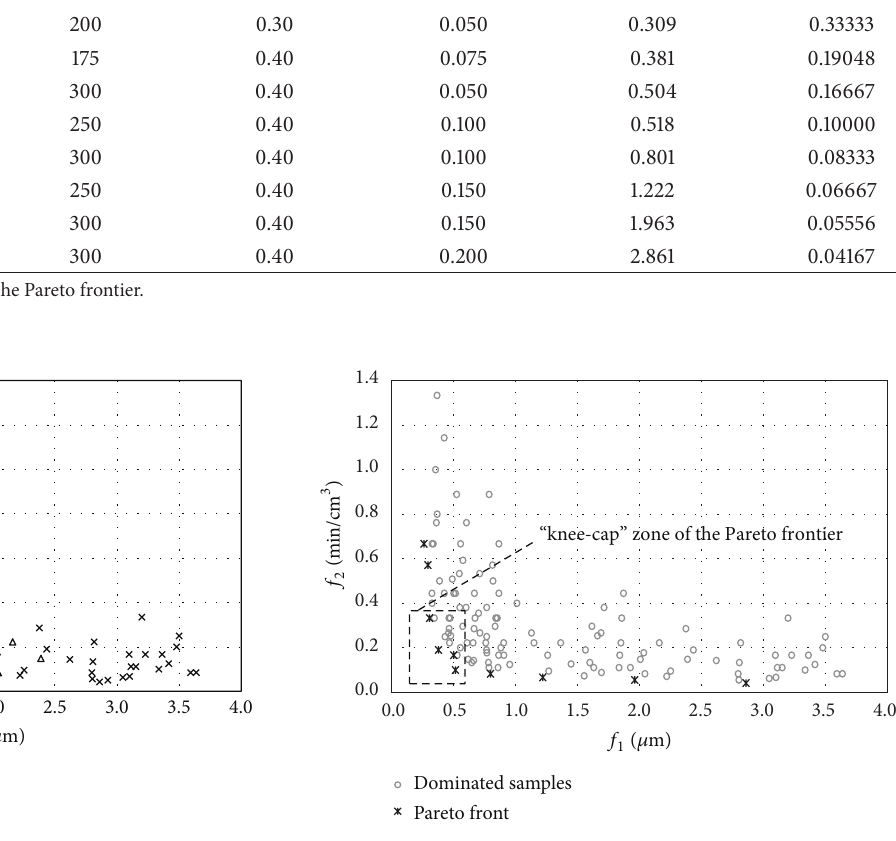
Figure 3: Pareto plot for five-level full-factorial